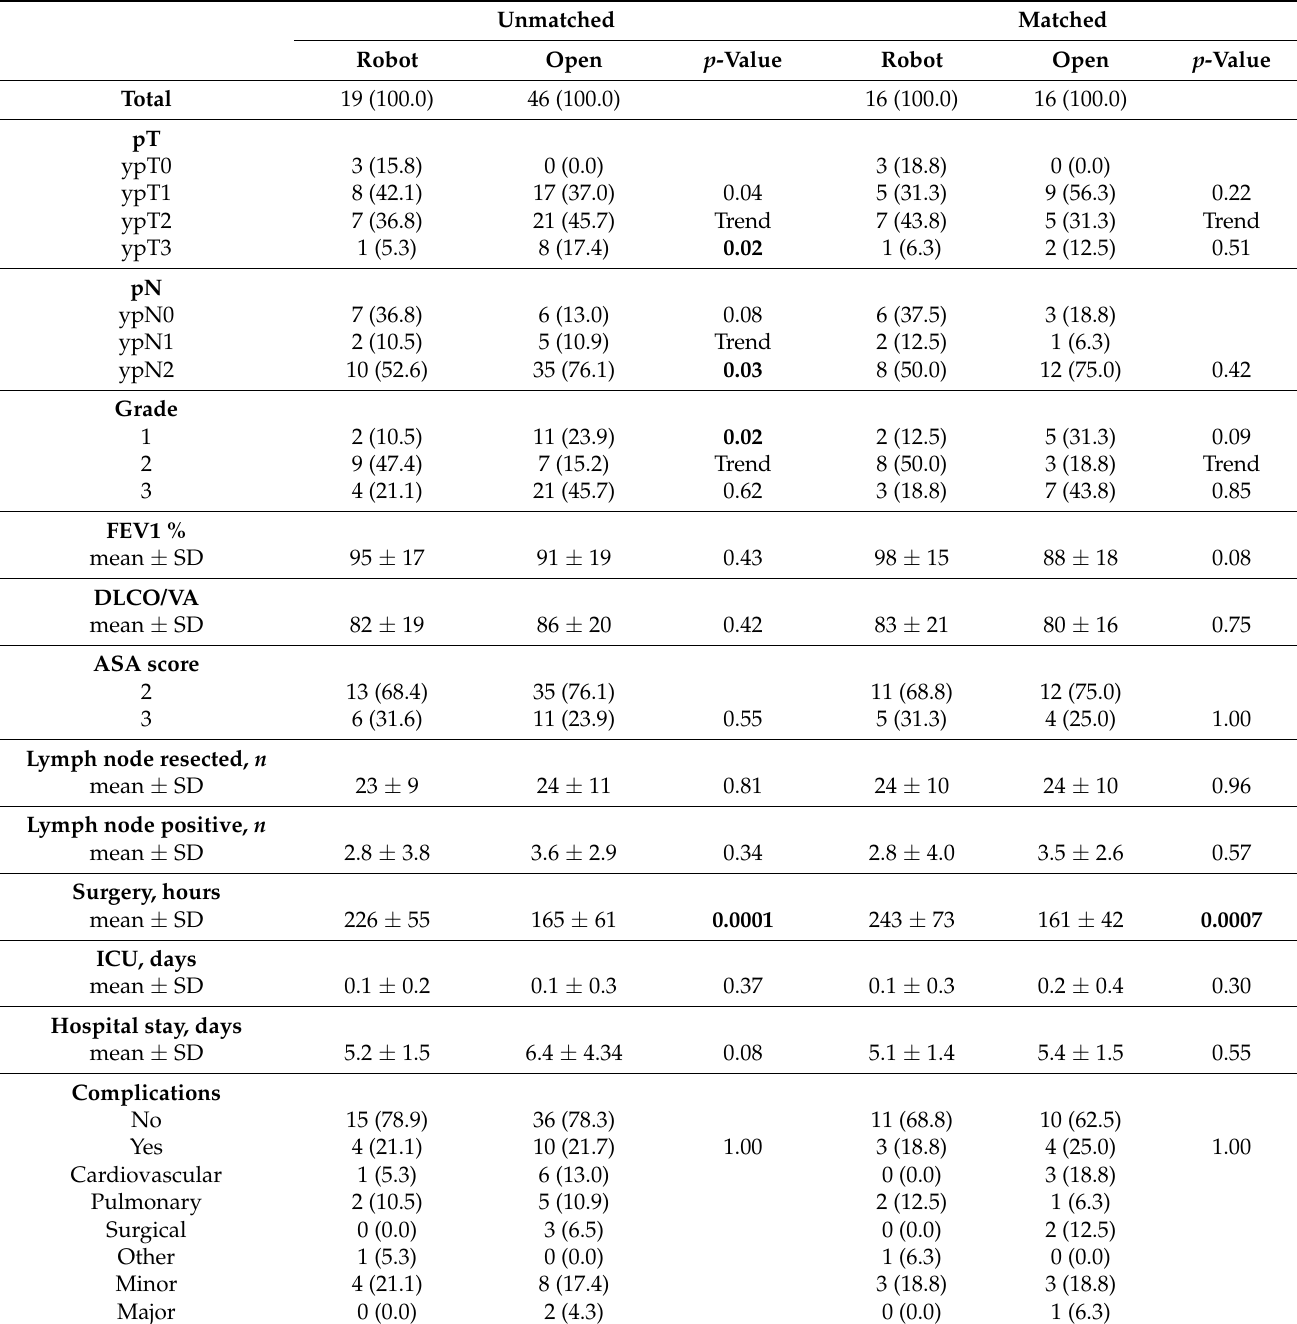
Table 2. Surgical and pathological characteristics of all patients and matched patients.